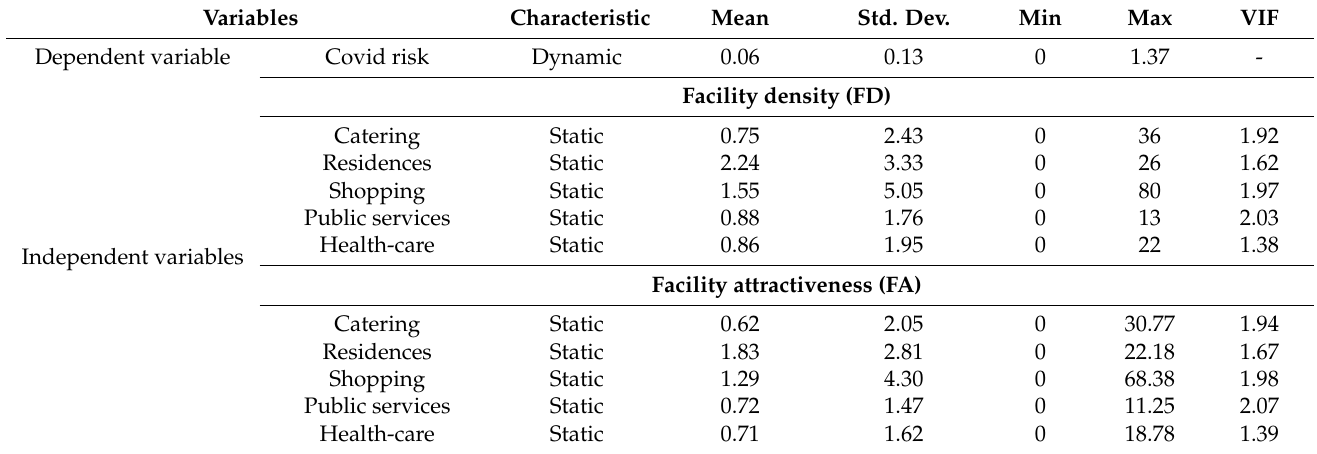
Table 2. Statistical description of the variables of FD and FA models.